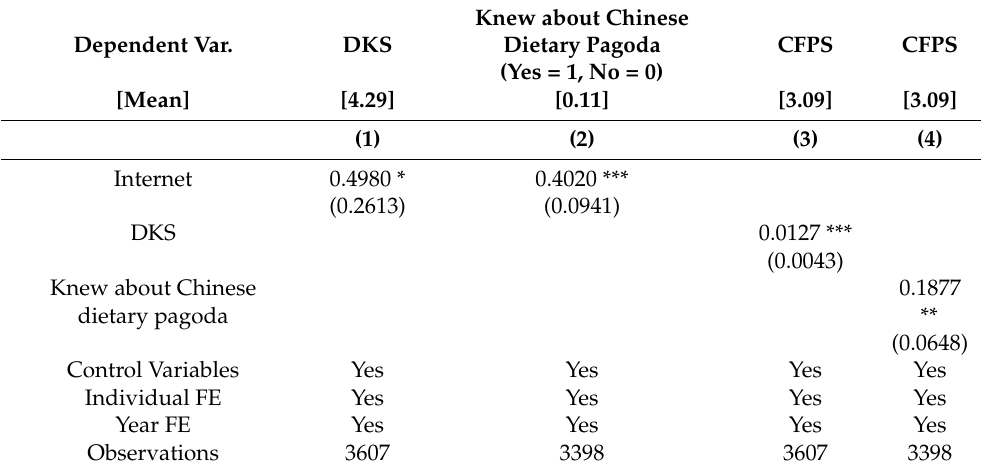
Table 5. Mechanism test: Internet use, diet knowledge, and diet quality. Dependent Var. DKS